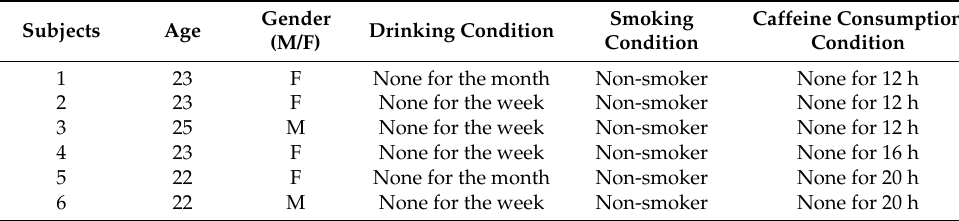
Table 2. Survey results of subjects’ characteristics before the experiment.